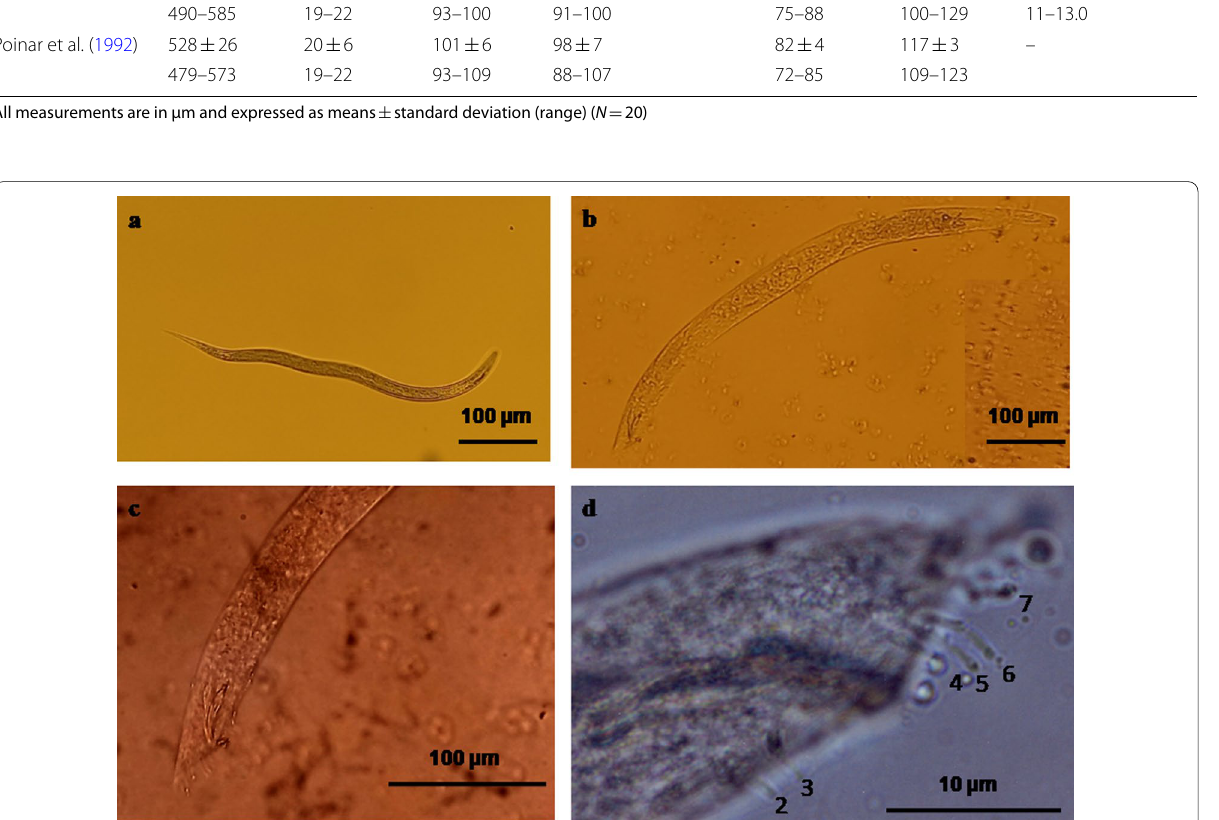
Fig. 1 H. indica a . Infective juvenile; b . Male; c . Tail end of male; d . Pattern of bursal